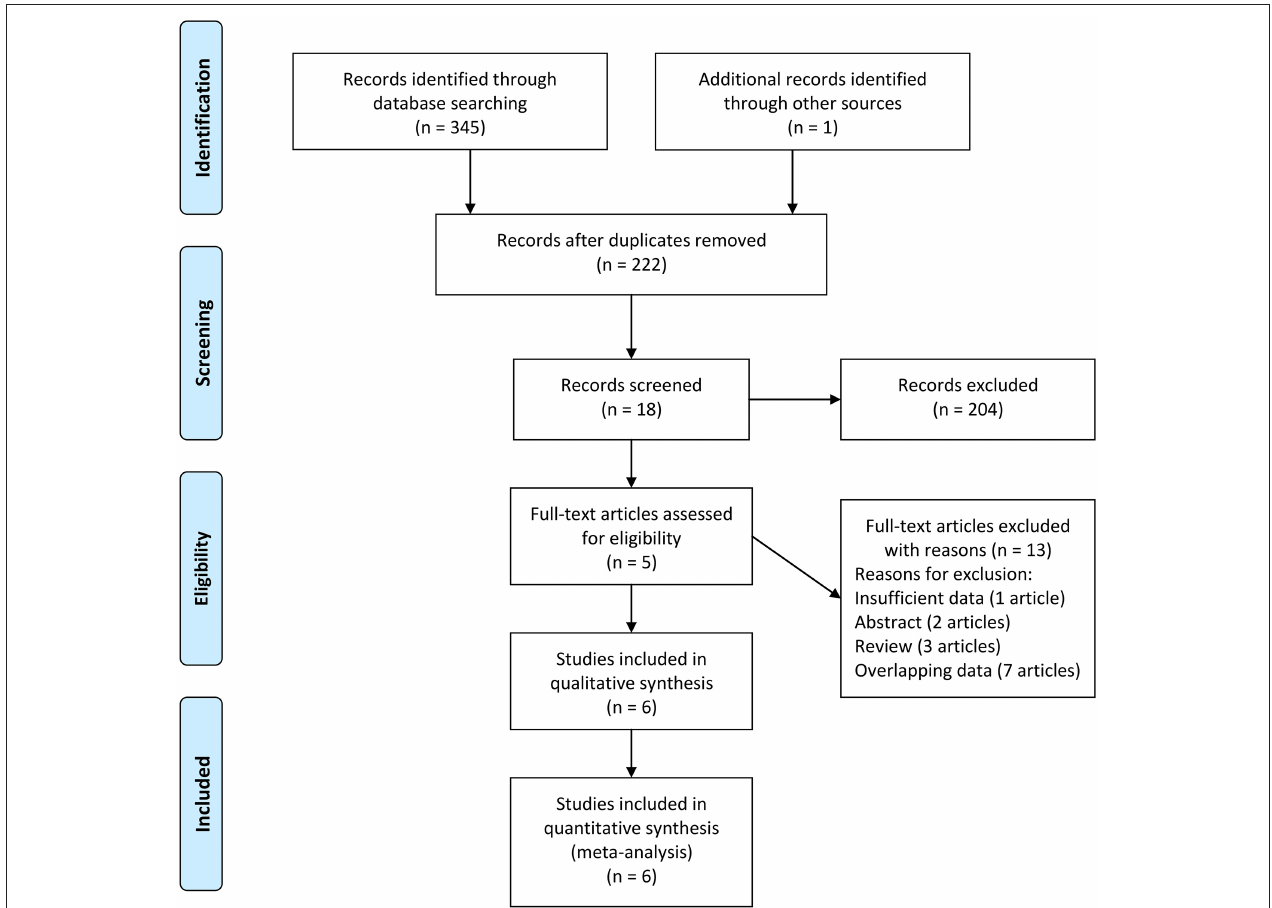
FIGURE 1 | Flow diagram of study